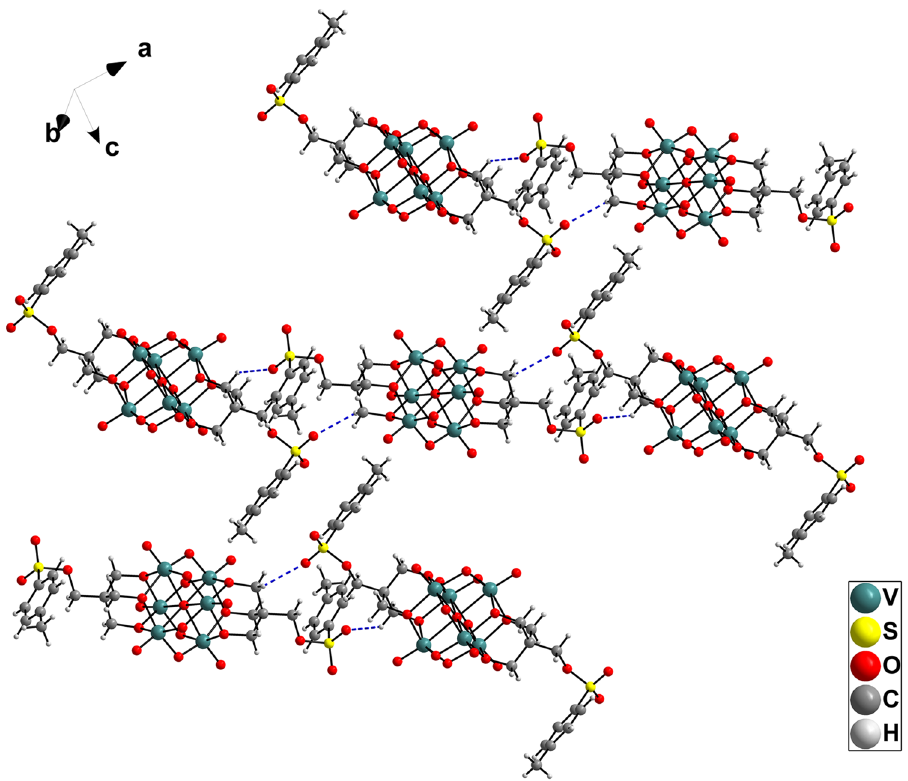
Figure 3. The 2D supramolecular layers (bottom) of compound 1 . Colour scheme: V = teal; S = yellow; O = red; C = grey; H = light